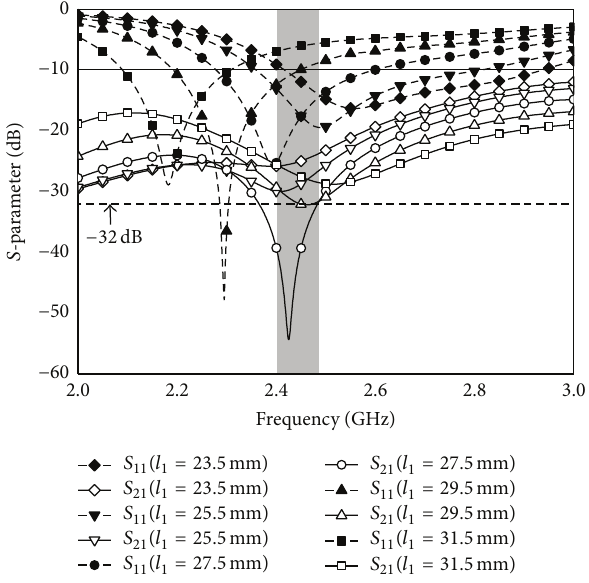
Figure 5: Simulated 𝑆 -parameters for various values of length 𝑙 1 ( 𝑙 2 = 15.5 mm).